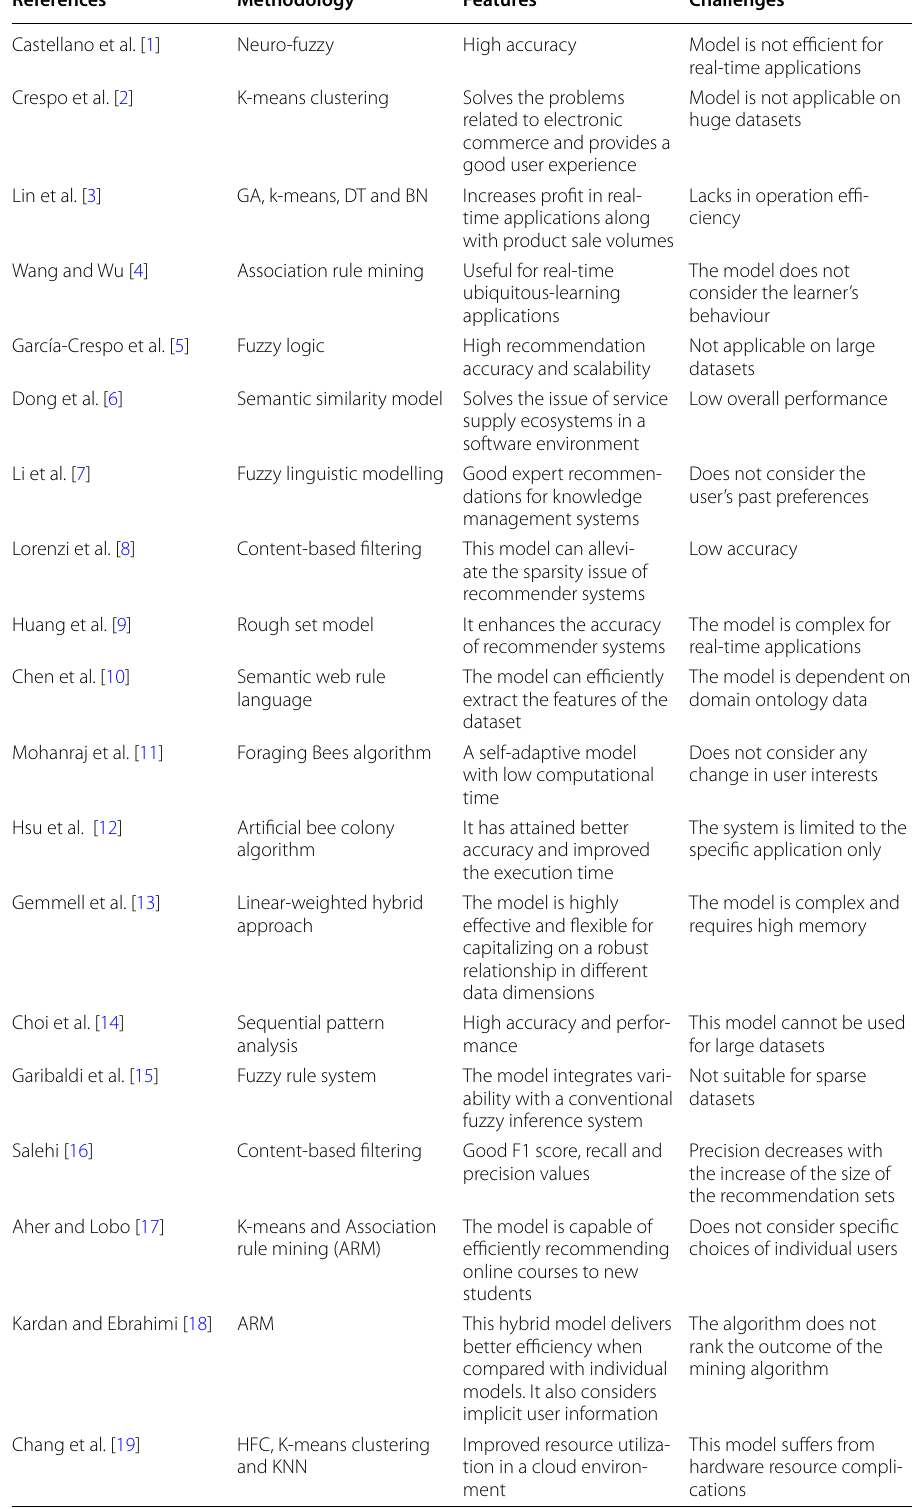
Table 6 Features and challenges of different recommender